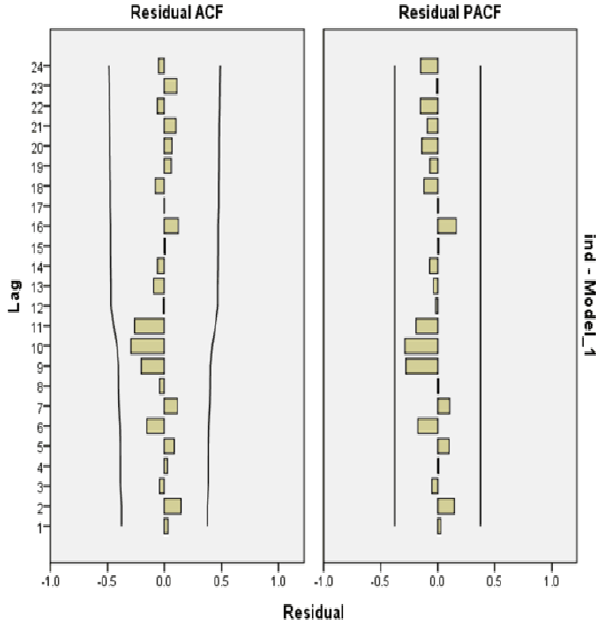
Figure 9. The residual ACF and Figure 9. the residual ACF and PACF. Figure 9. the residual ACF and PACF.